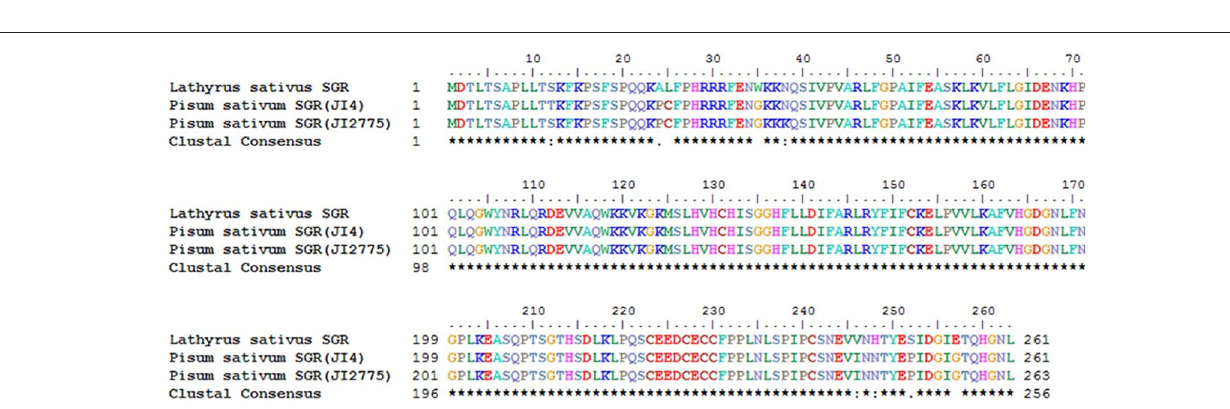
Frontiers in Plant Science |